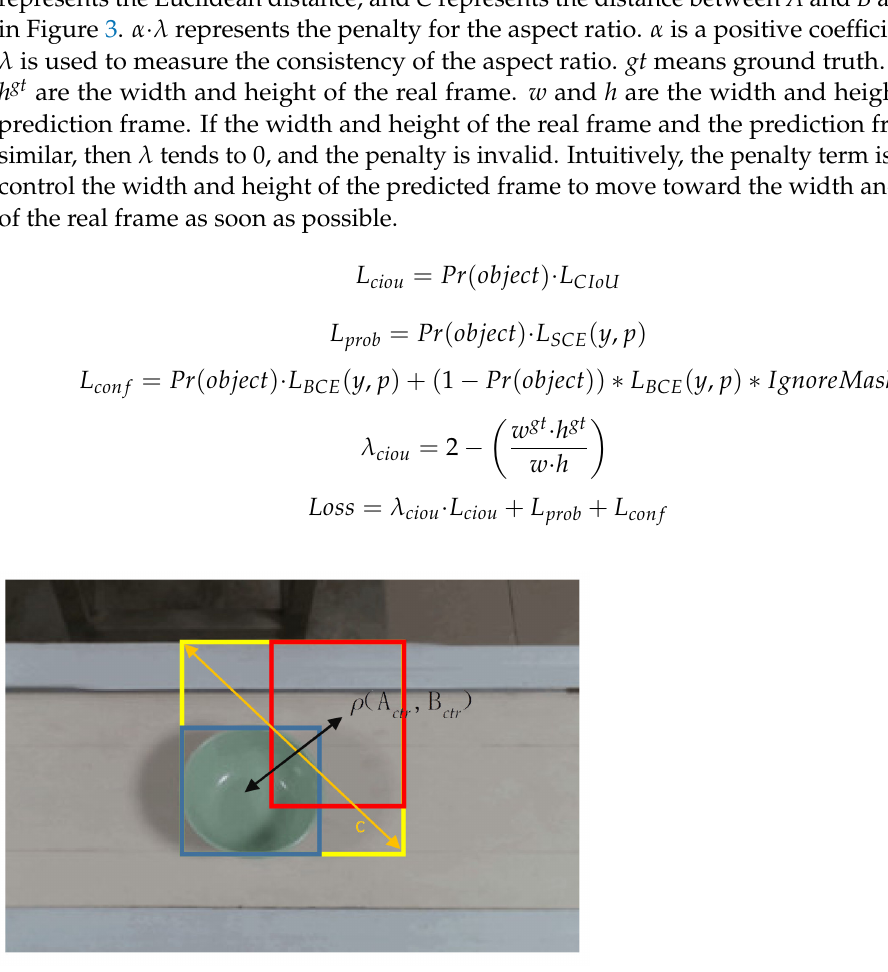
Figure 3. Euclidean distance schematic